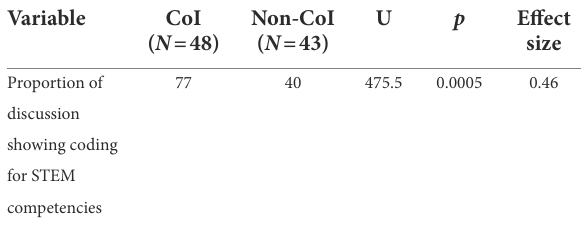
TABLE 2 Comparison of CoI and Non-CoI group proportion of total lines of transcript coded for STEM